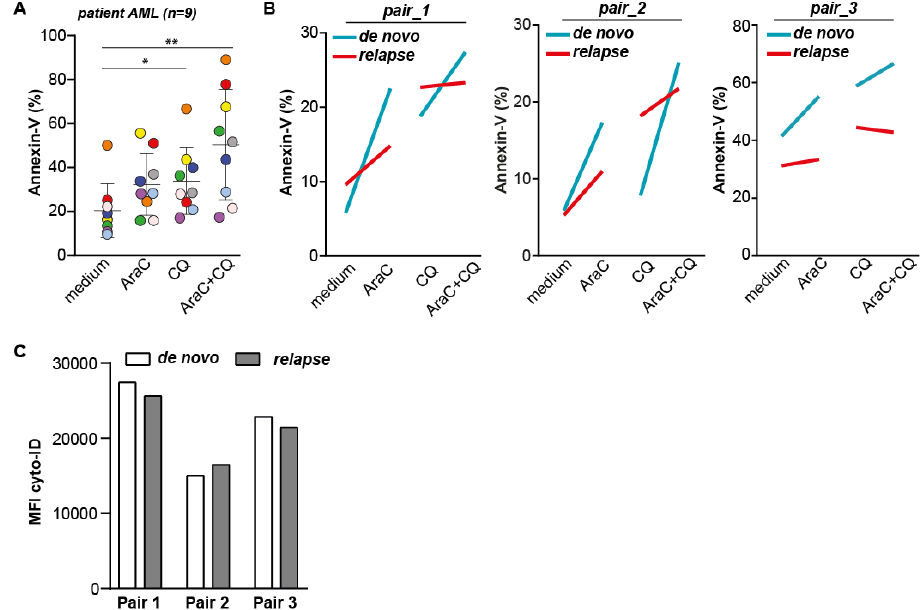
Figure 6. Co-treatment with AraC and chloroquine (CQ) gives the highest levels of cell death in patient-derived AML cells. ( A ) Induction of cell death in AML patient samples ( n = 9) treated with AraC (750 nM), CQ (10 µ M), or the combination as determined by Annexin-V staining after 72 h of incubation. Each color represents a different sample. ( B ) Induction of cell death in de novo versus matched relapse AML patient samples ( n = 3), treated with 750 nM AraC, 10 µ M CQ, or the combination. ( C ) Autophagosomal content as determined by cyto-ID of de novo versus matched relapse AML patient samples ( n = 3, using flow cytometry). Significance was tested using one-way ANOVA Tukey’s multiple comparison test. p values are indicated as: ** p < 0.01, and * p <